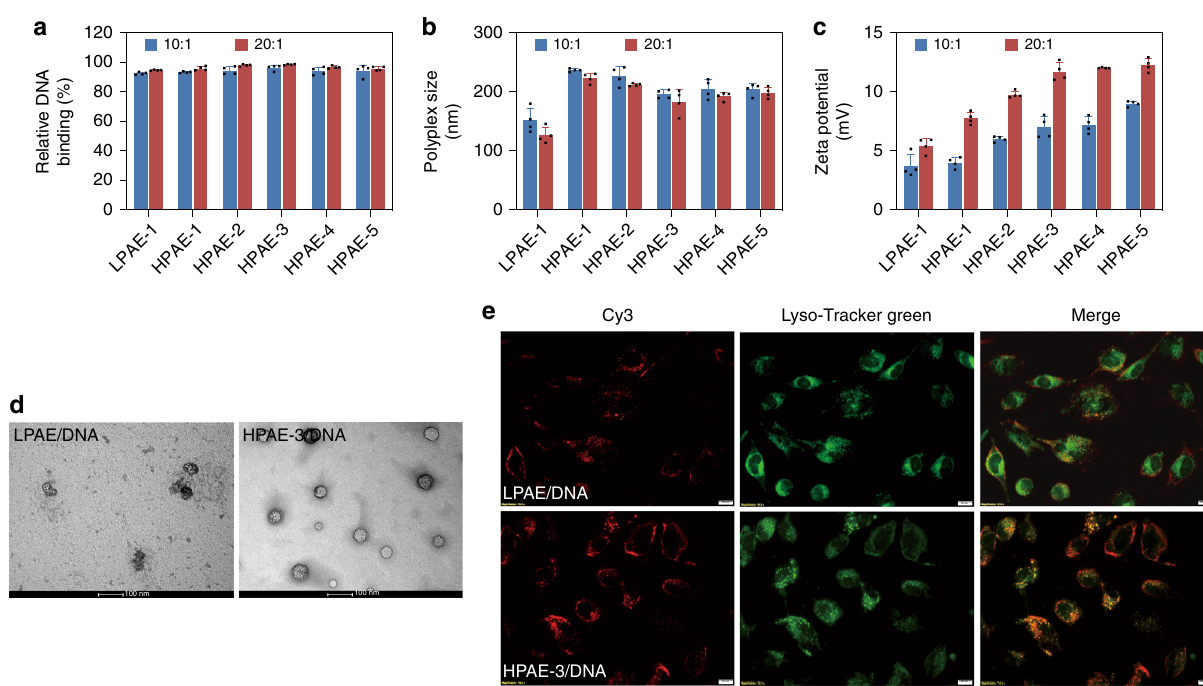
Fig. 2 Biophysical characterization of HPAEs differing in branched structure. a All the polymers have strong and similar DNA binding af fi nity. b All the polyplexes have sizes < 250 nm and LPAE/DNA polyplexes have a smaller size in comparison with HPAE/DNA counterparts. c As the branching degree increases, the zeta potential of polyplexes increases and reaches at a stable level at 12 mV. d LPAE/DNA and HPAE-3/DNA polyplexes manifest substantially different morphologies, the former is spherical while the latter is toroidal, the scale bars represent 100 nm. e HPAE-3/DNA polyplexes show much stronger cellular uptake and endo/lysosomal escape ef fi ciency, compared to the LPAE/DNA counterparts. The scale bars represent 20 μ m. Data are shown as average ± SD; n =